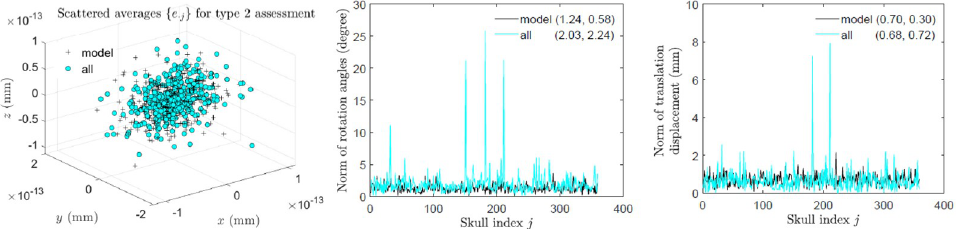
Fig 11. Type 2 assessment: Fluctuating asymmetry of skulls. Scattered points of averaged asymmetry indices and norms of rotation angles and translation displacements of the 359 perturbed symmetric skull and all real skulls are shown, where in brackets are the means and standard deviations of the norms.